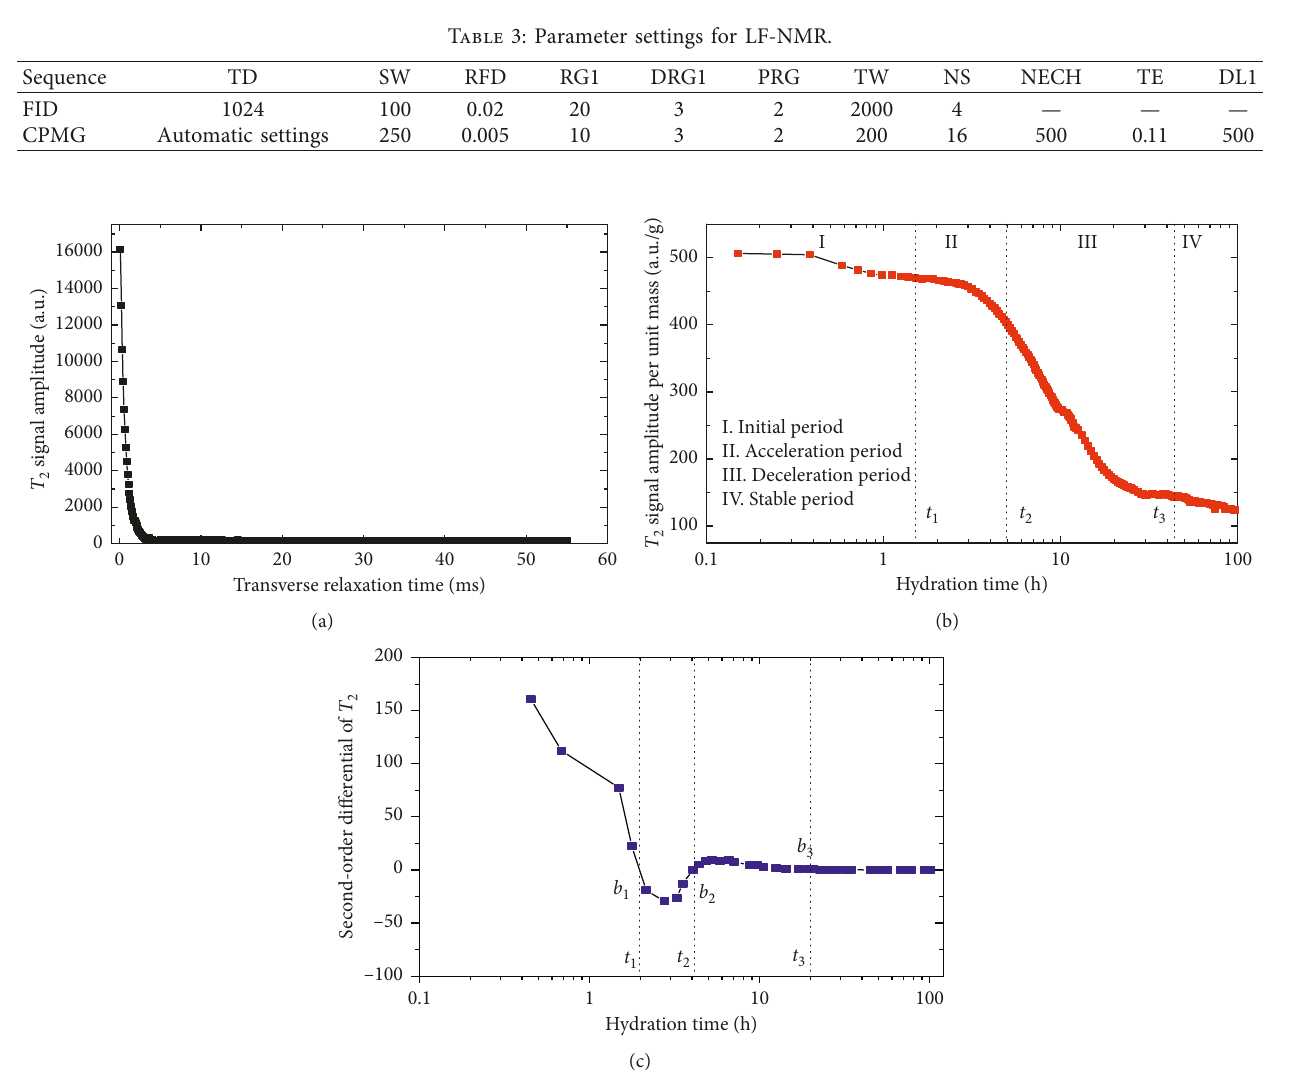
2 ) signal. (b) The first peak amplitude A ( t ) in unit